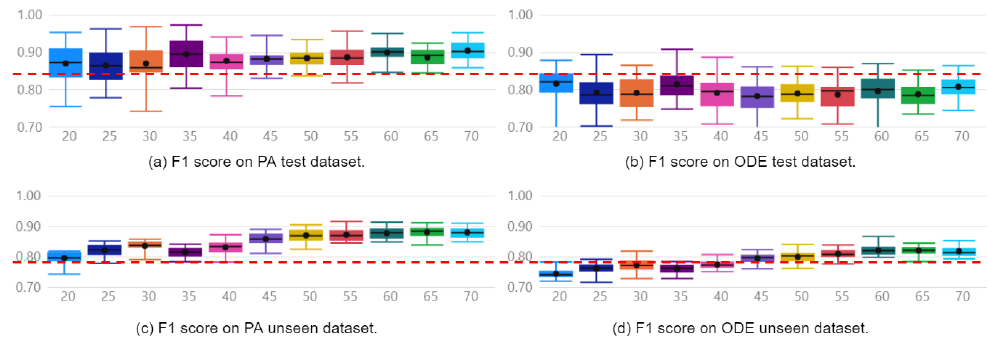
Figure 10. F1 Score of Pick And Place classifiers by number of instances for training, over: ( a ) PA test data, ( b ) ODE test data, ( c ) PA unseen data, ( d ) ODE unseen data.